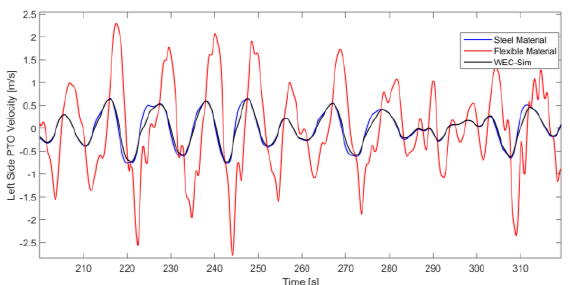
Fig. 12. Time series of PTO velocity for different material stiffnesses – left PTO unit – WEC-Sim rigid body solution (black), dynamic uncoupled analysis with steel (blue) and dynamic uncoupled analysis with flexible material